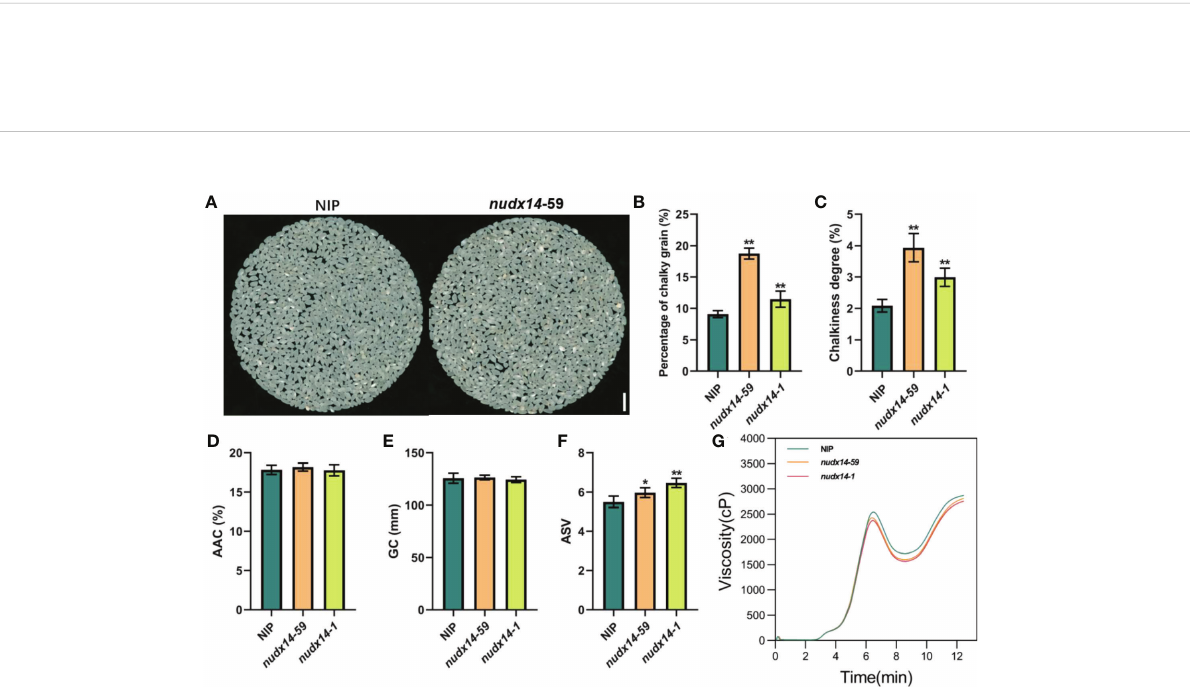
FIGURE 4 Grain quality between wild-type and nudx14 plants. (A) Grain morphology in WT and nudx14 plants. (B – F) Statistical analysis of percentage of chalky grain (B) , chalkiness degree (C) , apparent amylose content (ACC, D ), gel consistency (GC, E ) and alkali spreading value (ASV, F ) in WT and nudx14 plants. Signi fi cance is determined by two-sided Student ’ s t test, **P<0.01. (G) Viscosity (cP) measurement between WT and nudx14